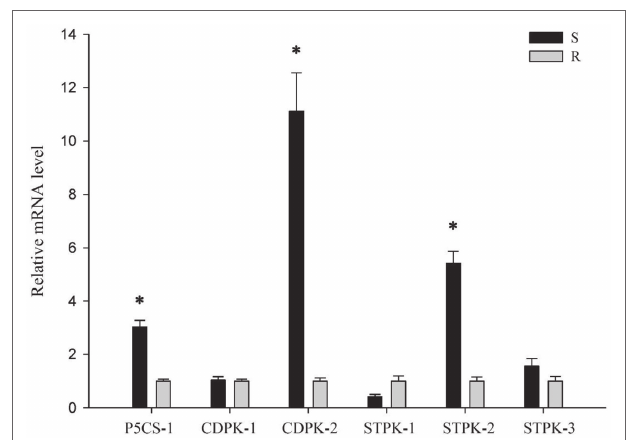
FIGURE 6 | The relative expression level of stress response genes in the R and S Polypogon fugax populations using quantitative reverse-transcription polymerase chain reaction (qRT-PCR). The qRT-PCR was performed using three independent biological replicates and repeated at least twice (two technical replicates). Data are the mean values of six biological replicates. The standard errors of the means are described by vertical bars. The abbreviations R and S represent for the resistant and sensitive P. fugax populations, respectively. * Indicates significant differences ( p = 0.05) by Turkey’s test.